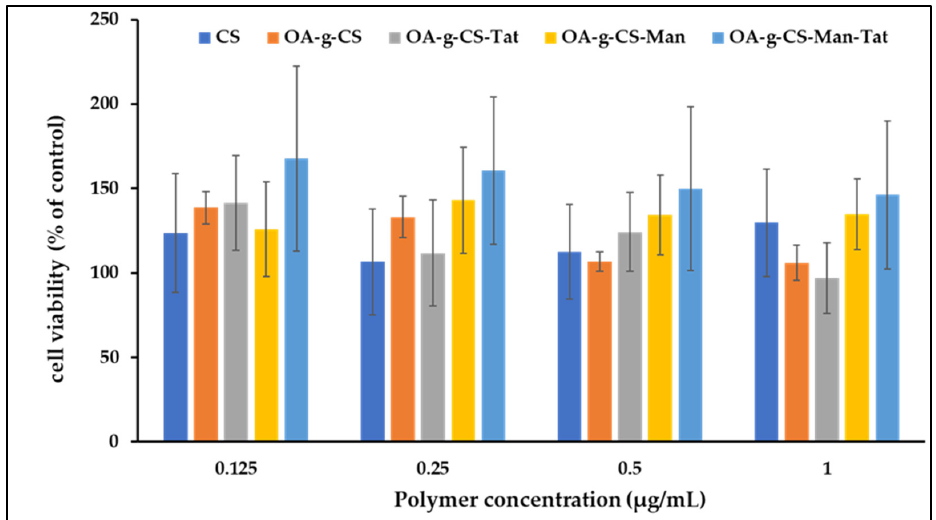
Figure 7. In vitro cytocompatibility of CS, OA-g-CS, OA-g-CS-Man, OA-g-CS-Tat, and OA-g-CS- Man-Tat polymeric micelles at different concentrations (0.125–1000 µg/mL) in bEnd.3 cells. MTT was used to evaluate cell viability, data presented as mean ± SD (n = 4).